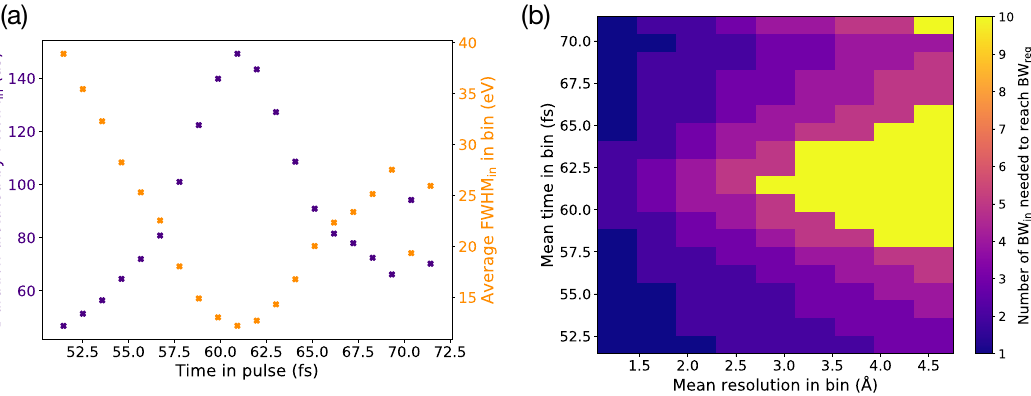
Figure 5. Predicted integration of two reflections at different resolutions for 0.3 ◦ mosaicity between 55 and 57 fs after arrival of the pulse at the sample. The mean instantaneous bandwidth in this interval is 22 eV. The decrease in IF due to the linear chirp across the interval is also shown. ( a ) Partiality as a function of time ( b ) “Instantaneous intensity” as a function of time normalized to the partiality.